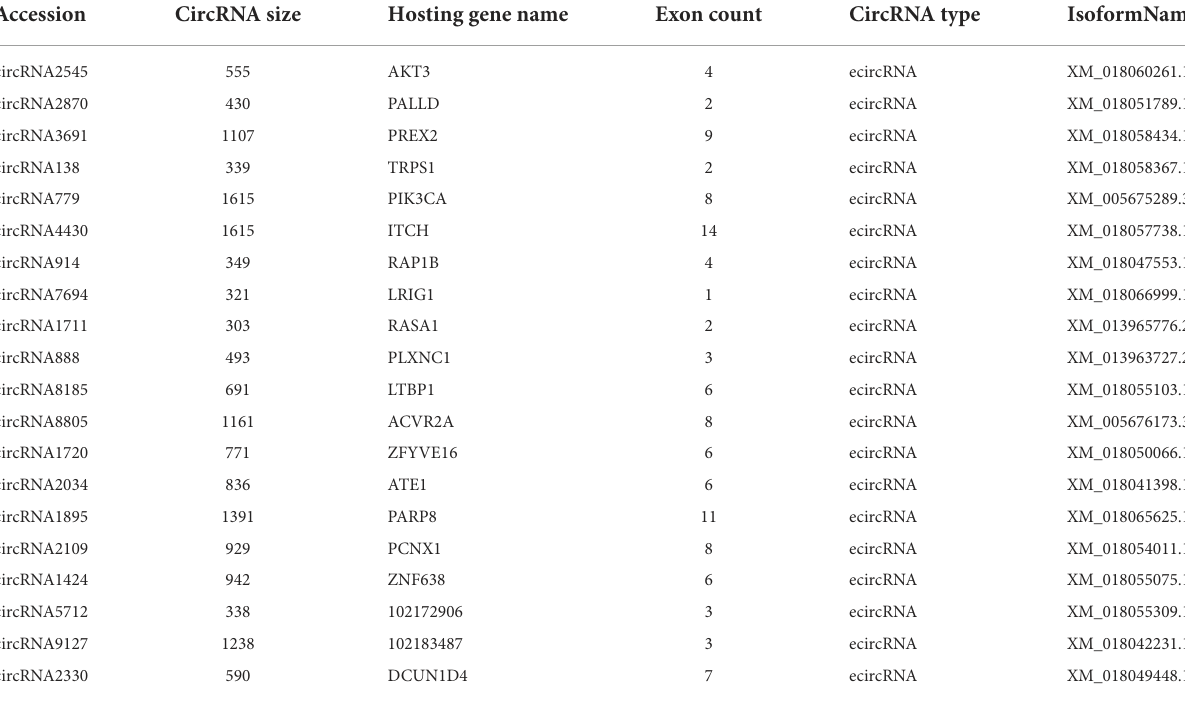
TABLE 1 Information on circRNA related to secondary hair follicle